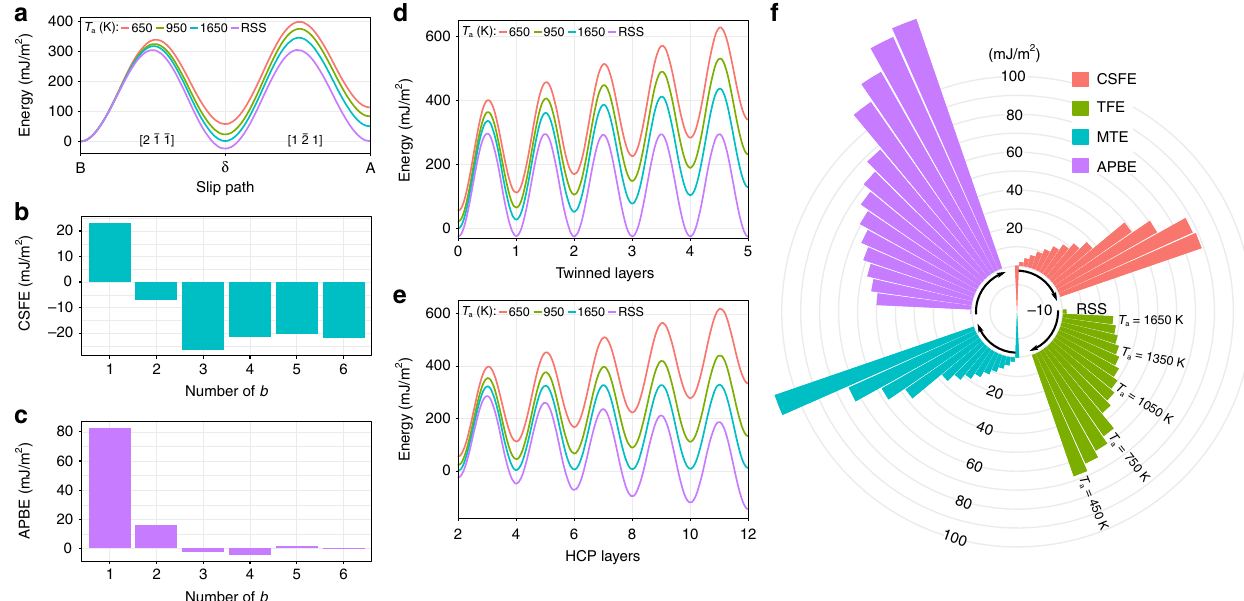
Fig. 2 Energy landscape depends on the annealing temperature used to prepare the medium-entropy alloy (MEA). a Full dislocation energy pathways for the fi rst Burgers vector. b , c Complex stacking fault energy (CSFE) and antiphase boundary energy (APBE) changes upon increasing number of Burgers vector (on the same slip plane) for a sample with T a = 950 K. d , e Energy pathways for twinning and face-centered cubic (FCC) → HCP (hexagonal close- packed) martensitic transformation, respectively. Both deformation twinning (DT) and martensitic transformation (MT) are based on the CSF in a . f The average complex stacking fault energy, twin fault energy, martensitic transformation energy, and antiphase boundary energy for random solid solution (RSS) and samples with different T a (450 − 1650 K). The unit of the iso-energy circles is mJ/m